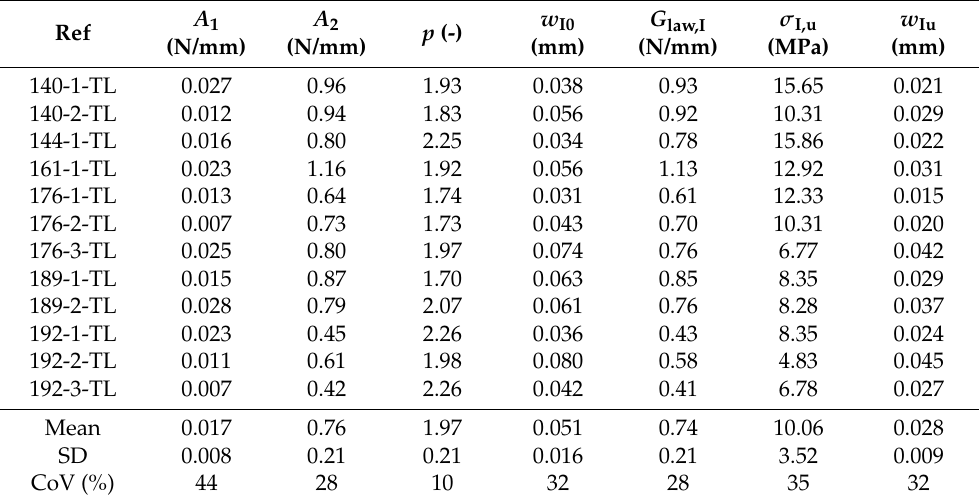
Table 6. Logistic function parameters ( A 1 , A 2 , p , and w I0 ), maximum stress ( σ Iu ) and relative displacement ( w Iu ), as determined by CBBM equations, from specimens with a TL crack